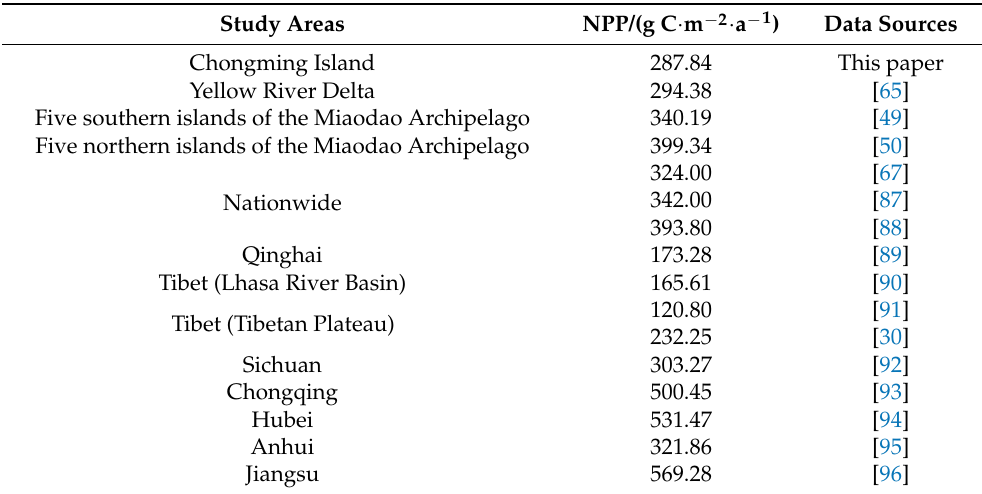
Table 6. NPP estimation results in different